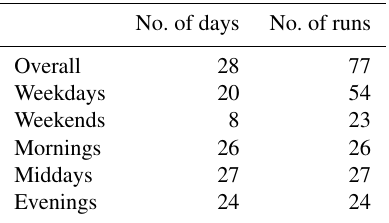
Table 2. Summary of mobile measurement runs during the CARE